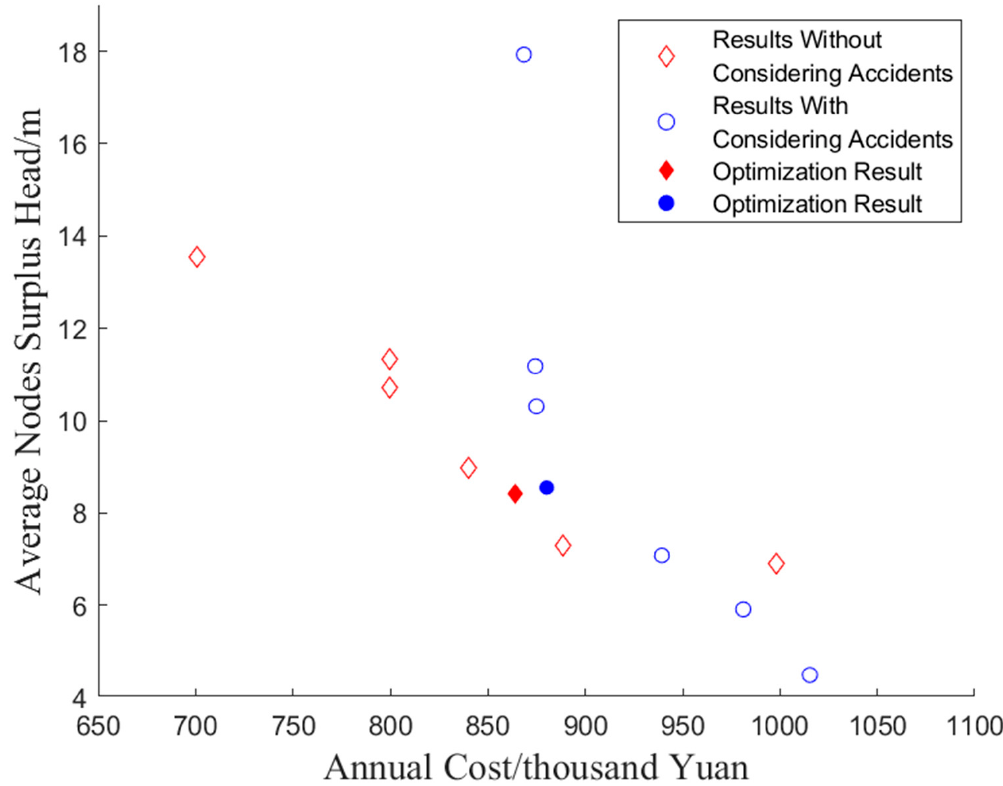
Figure 9. Pareto Diagram of Multi-Objective Optimization Results of Multi Pump Stations WDN with and without Considering Accident Conditions.